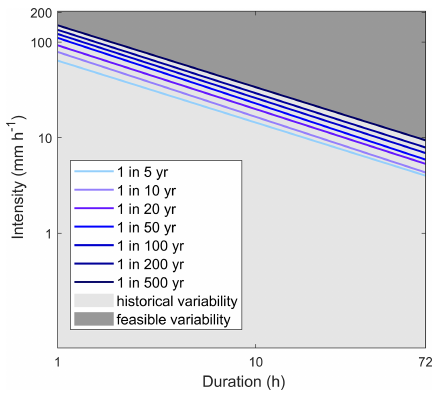
Figure 2. Rainfall intensity–duration–frequency (IDF) curves for Saint Lucia developed by Klohn–Crippen (1995) using Gumbel analysis of 40 years of daily rainfall data from 15 rainfall gauges. The light-grey section includes rainfall events from observed data (below IDF curves); the dark-grey section represents combinations of rainfall intensity–duration not recorded in the past but that might occur in the future (above IDF curves).